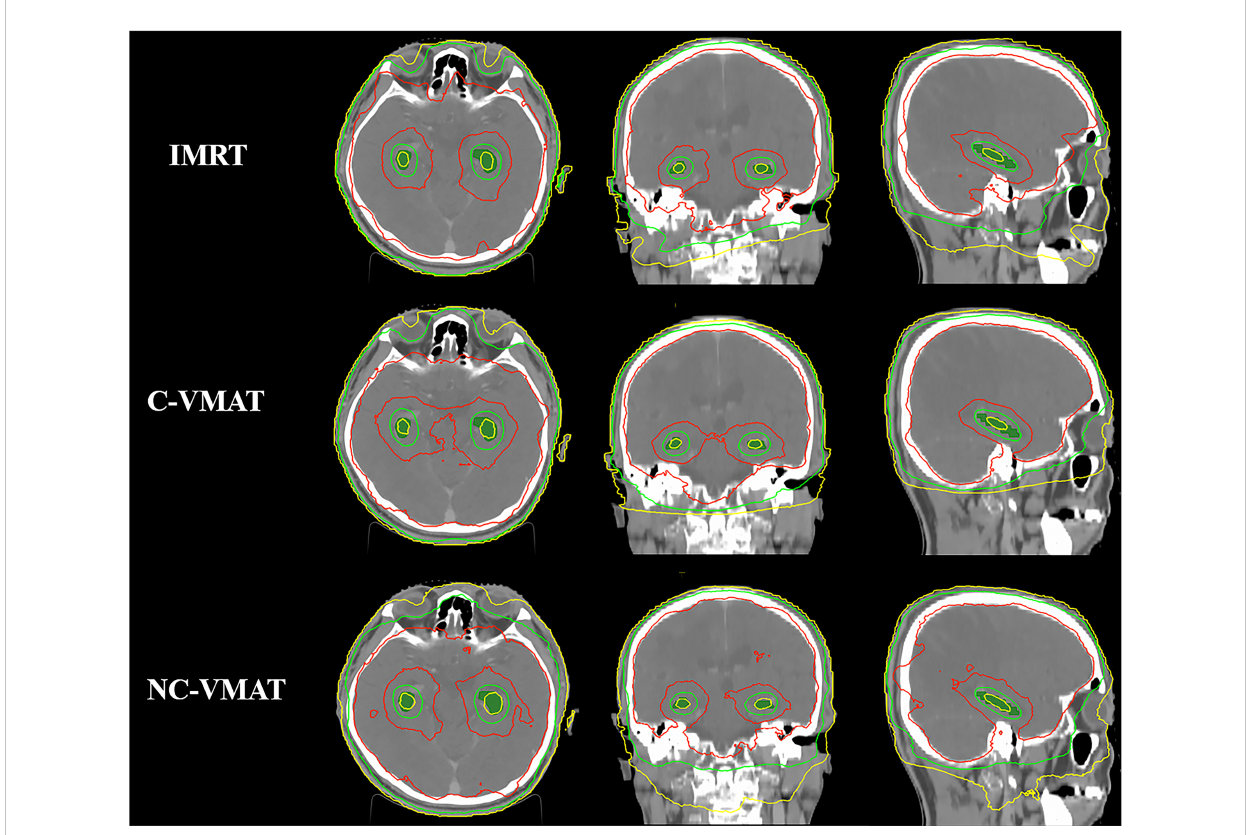
FIGURE 3 Comparison of some special isodose lines distribution between IMRT, C-VMAT and NC-VMAT plans. a. The red line represents the isodose line of 30Gy b. The green line represents the isodose line of 17Gy c. The yellow line represents the isodose line of